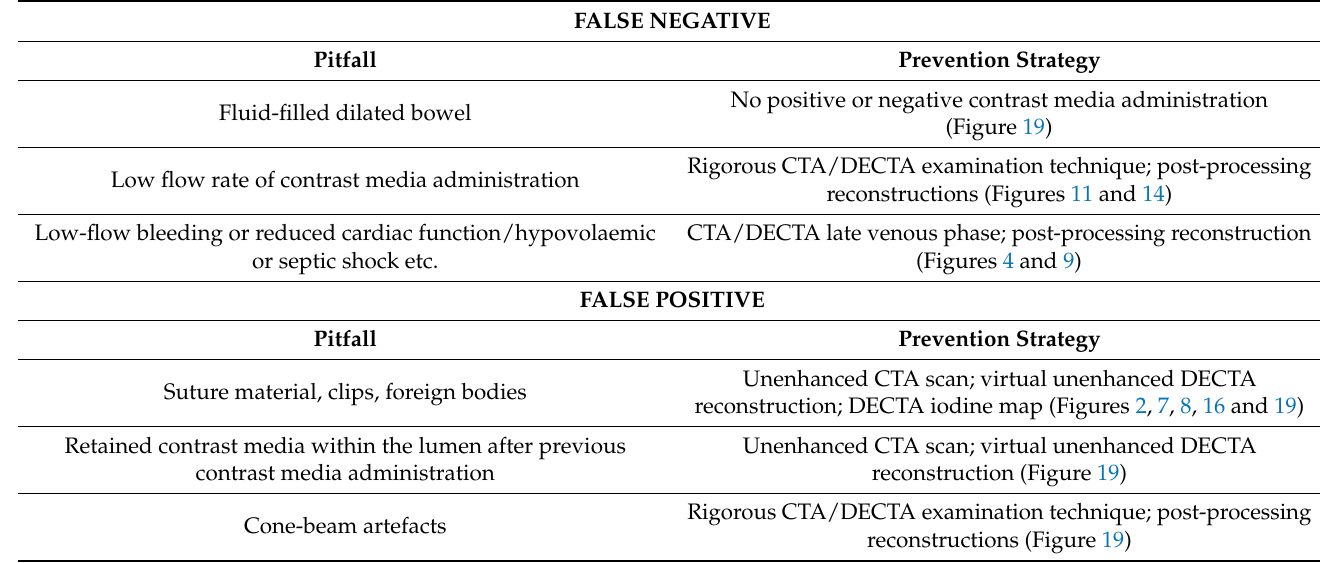
Table 4. Pitfalls in the detection of acute gastrointestinal bleeding with